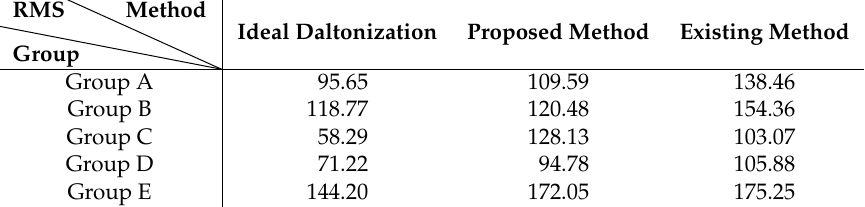
Table 1. RMS results for each image; a smaller RMS represents a bigger